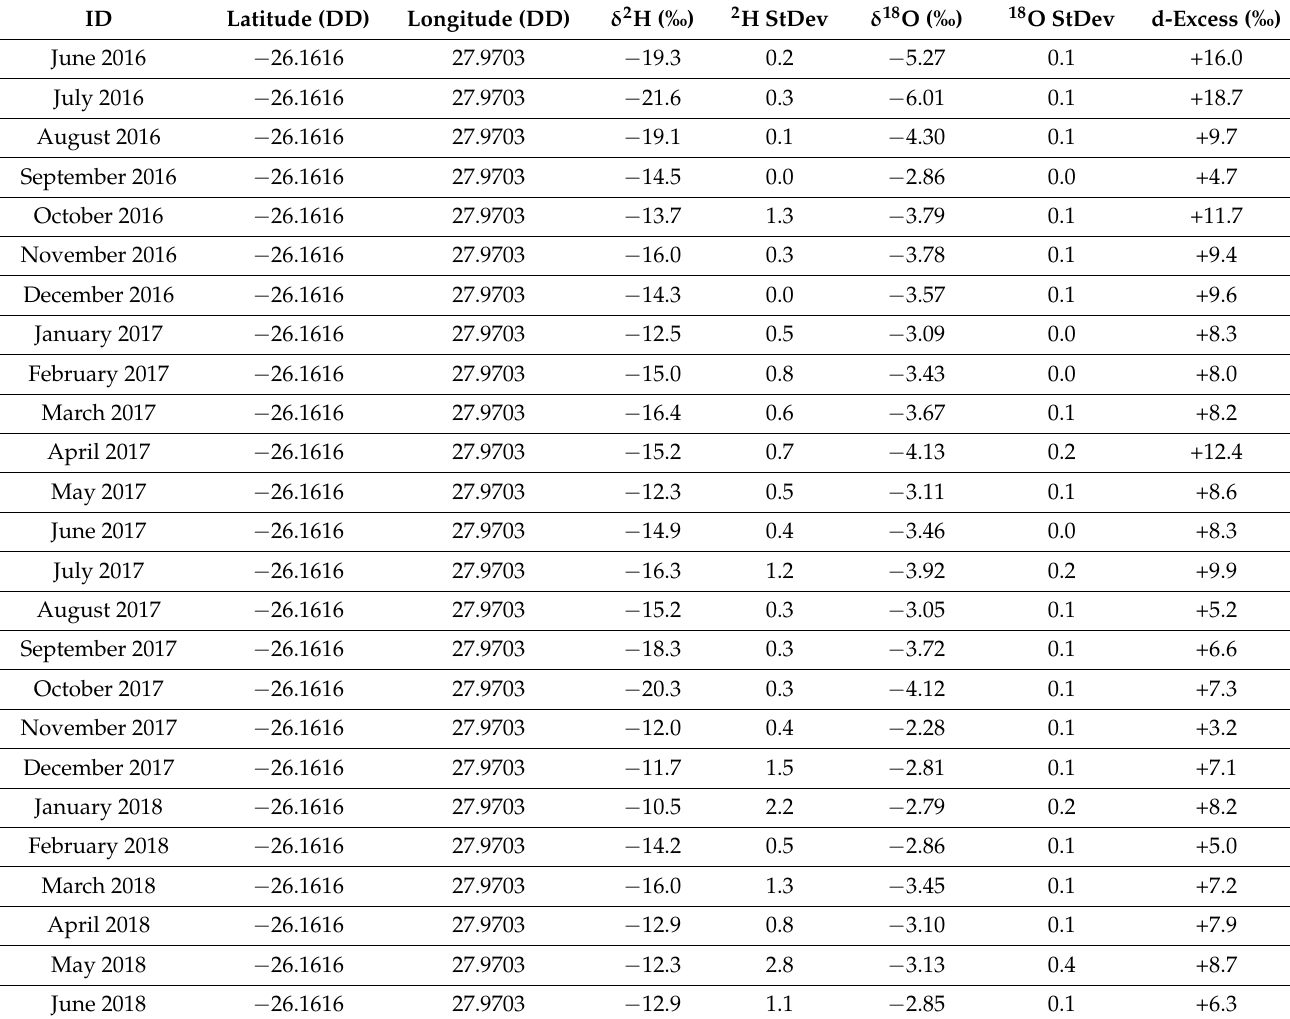
Table 1. Monthly stable isotope data for Albert Farm